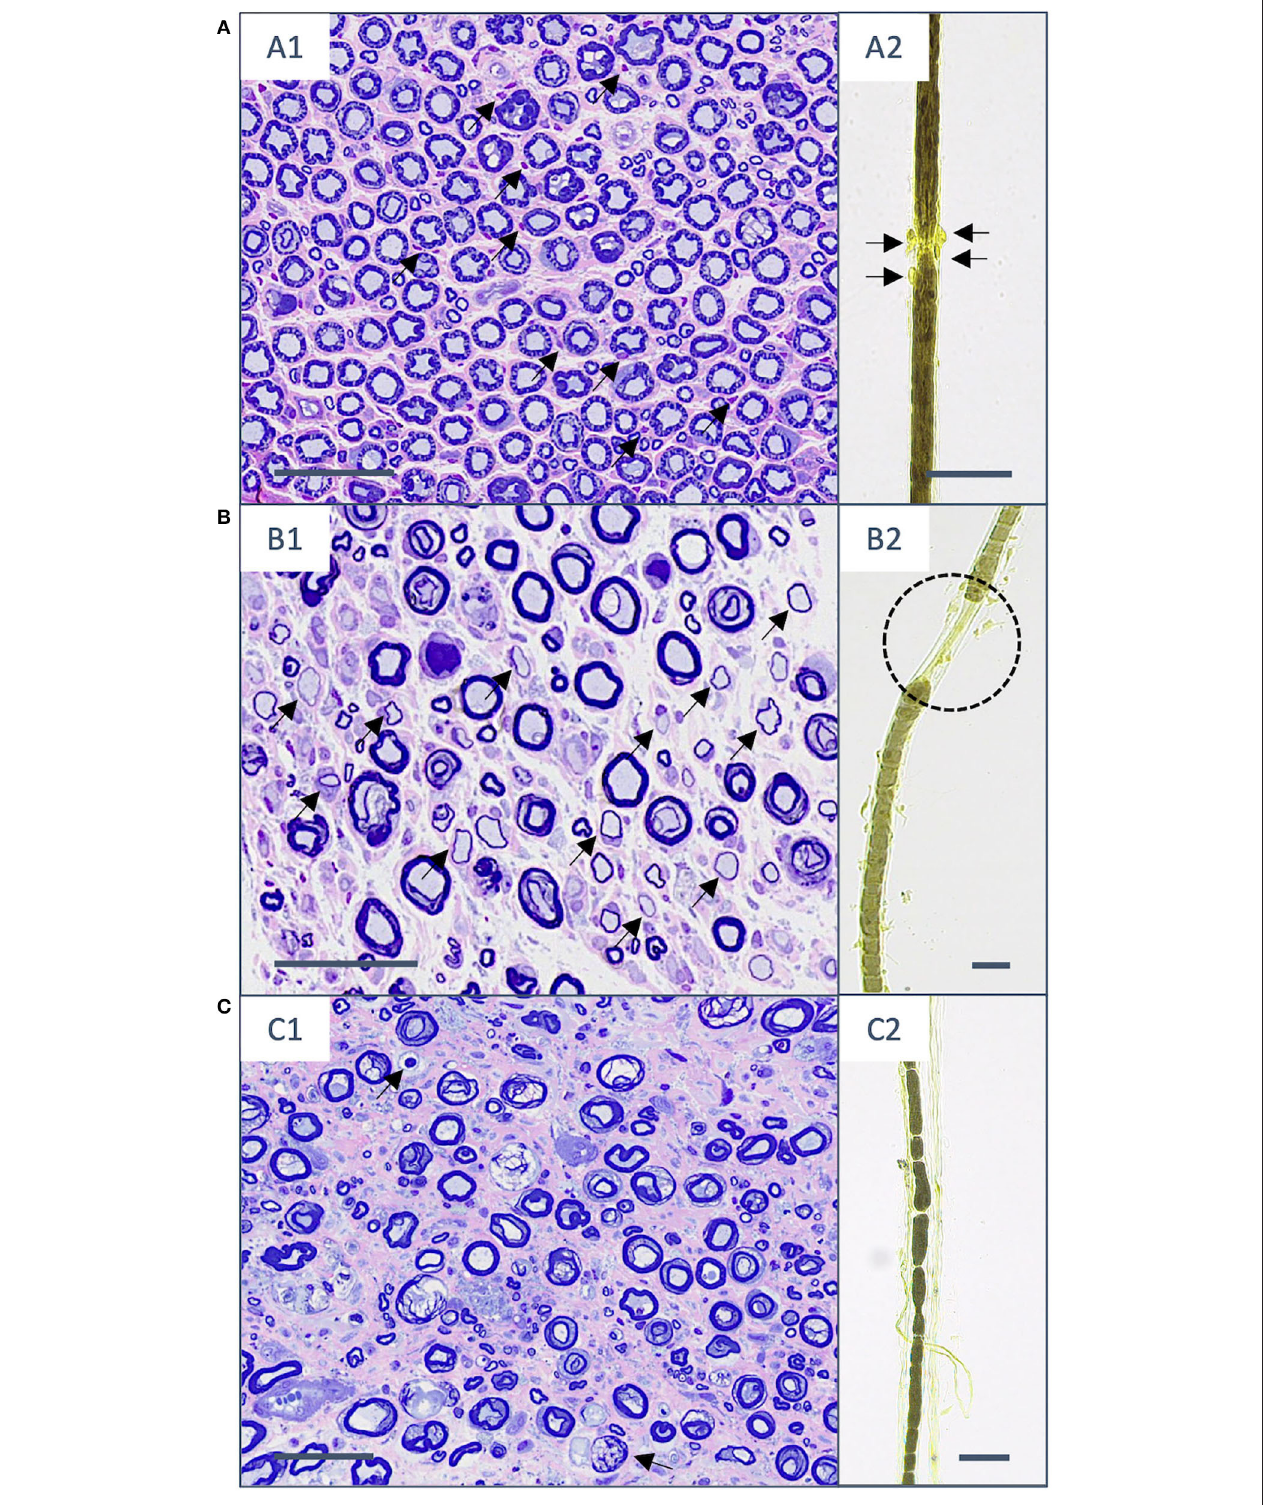
FIGURE 2 | Histopathological changes in semithin sections (stained with toluidine blue and safranin O) and nerve fiber teasing preparations (contrasted with Osmium tetroxide) in the three different clusters. (A) Cluster 1. (A1) Transverse section of fibular nerve with interstitial and fiber-adhesive mononuclear infiltrates (arrows).